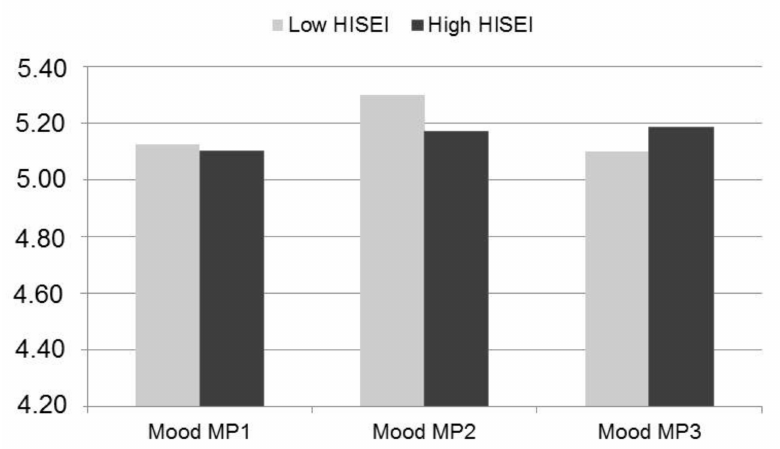
Figure 4. Mean scores in mood of students with above average and below average highest international socio-economic index of occupational status (HISEI)-scores at